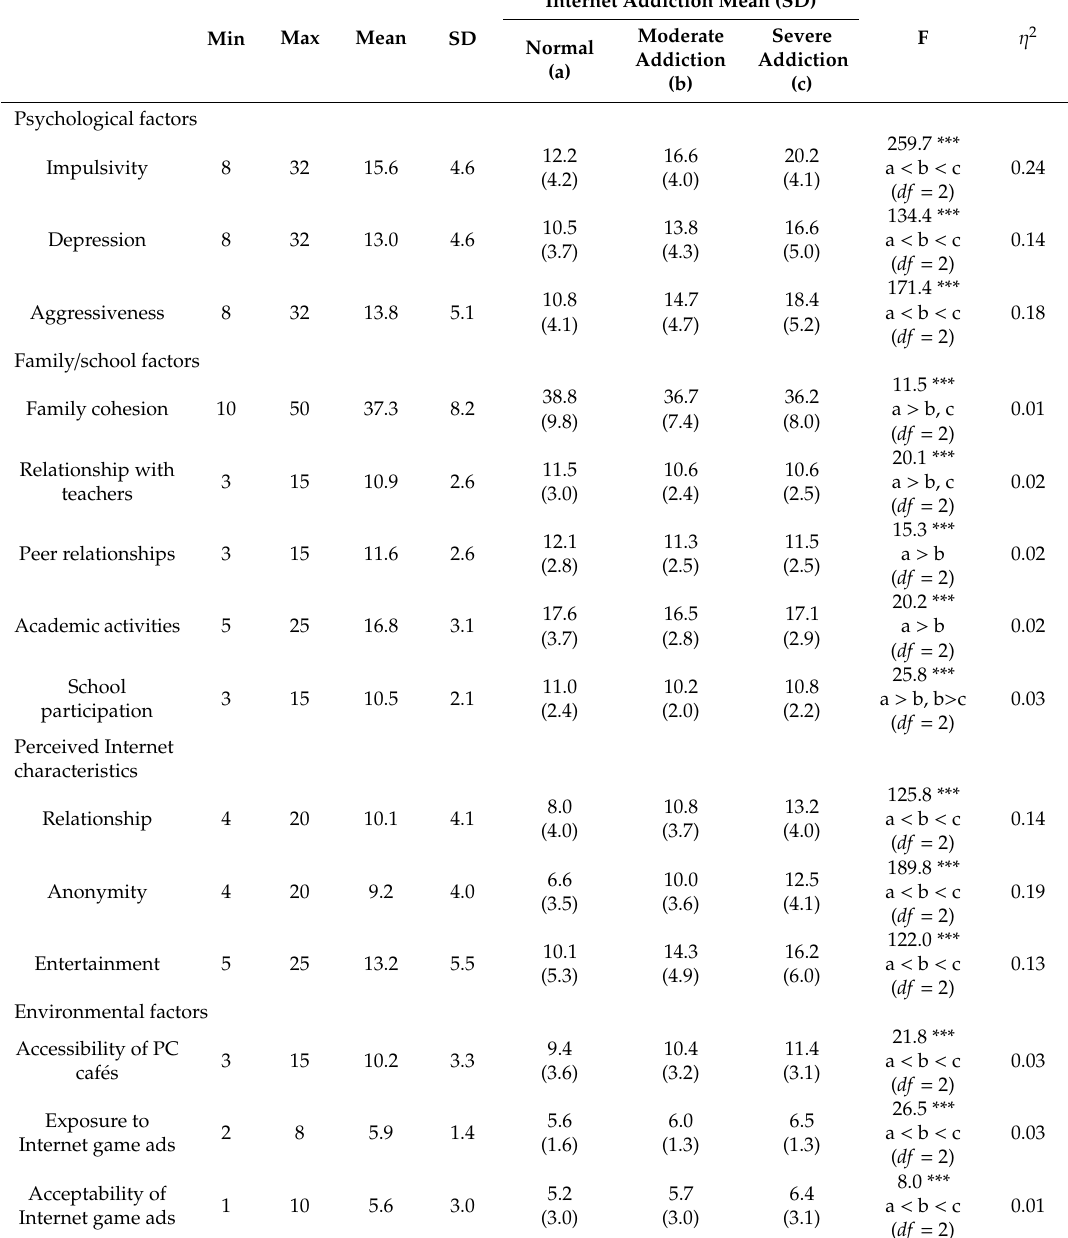
Table 3. Relationship between psychological, family / school, Internet, and environmental characteristics, and Internet addiction ( N =